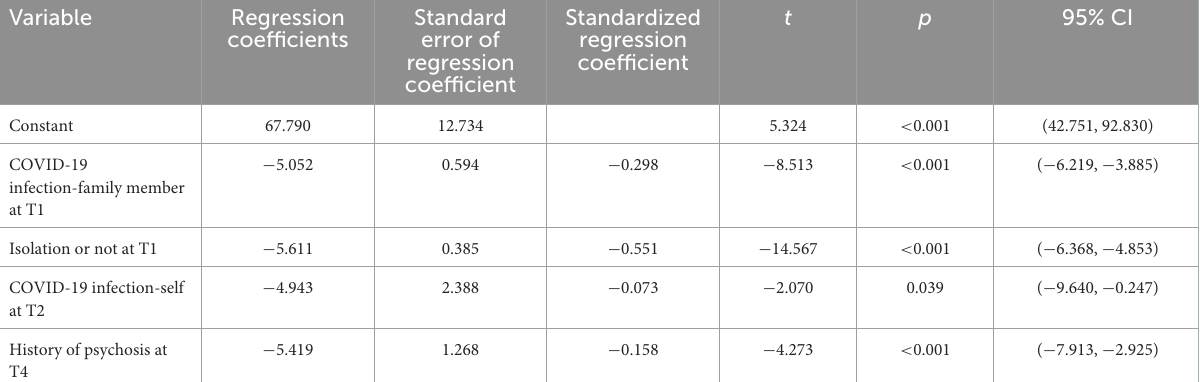
TABLE 5 Multiple linear regression analysis of influencing factors of GAD-7.